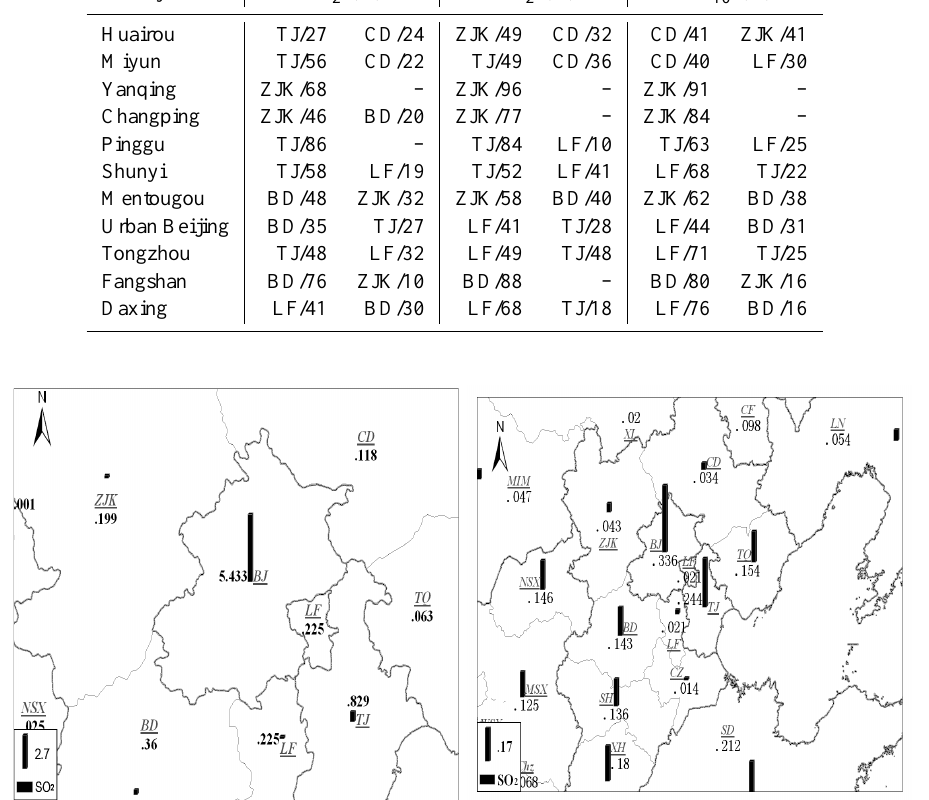
Fig. 6. The contribution to the SO 2 monthly mean concentration (ppbv) in Beijing at surface layer (left), and at the upper layer about 1.1km height (right). The black bars and numbers in each county indicate the contribution of SO 2 in Beijing that comes from that county. in estimating the contributions to air pollution over